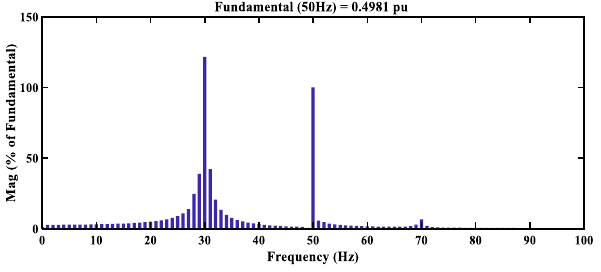
Figure 10. Fast Fourier transform (FFT) analysis of stator currents, at 50% series-compensation level.